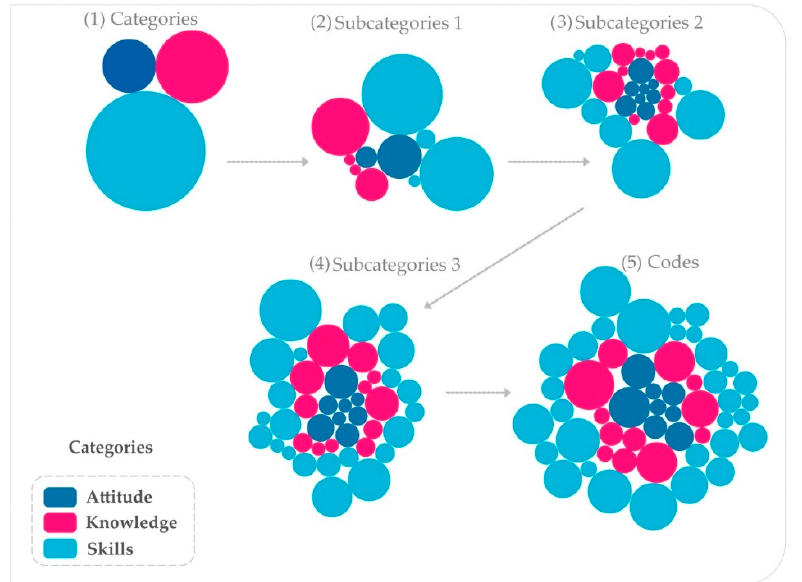
Figure 3. Operationalization of qualitative variables. The analysis considered five levels of analysis, from 3 categories to 51 codes. The higher levels were contained in the lower levels. Analysis complexity increases and is broken down into (1) 3 categories: (2) 10 subcategories level one, (3) 27 subcategories level two, (4) 42 subcategories level three, and (5) 51 codes.